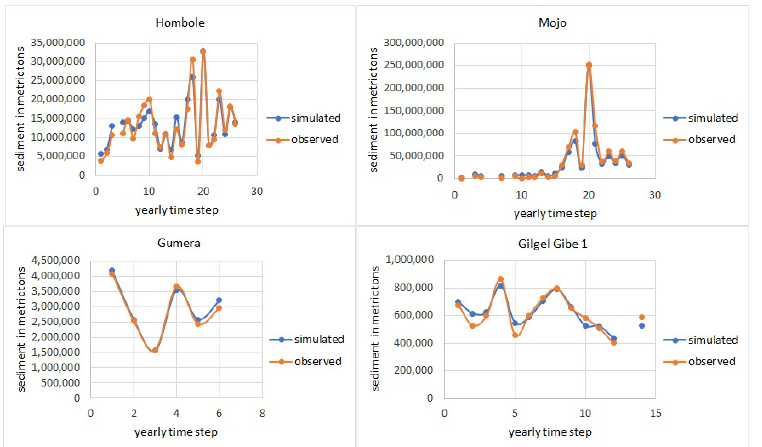
Figure 20. Observed and simulated